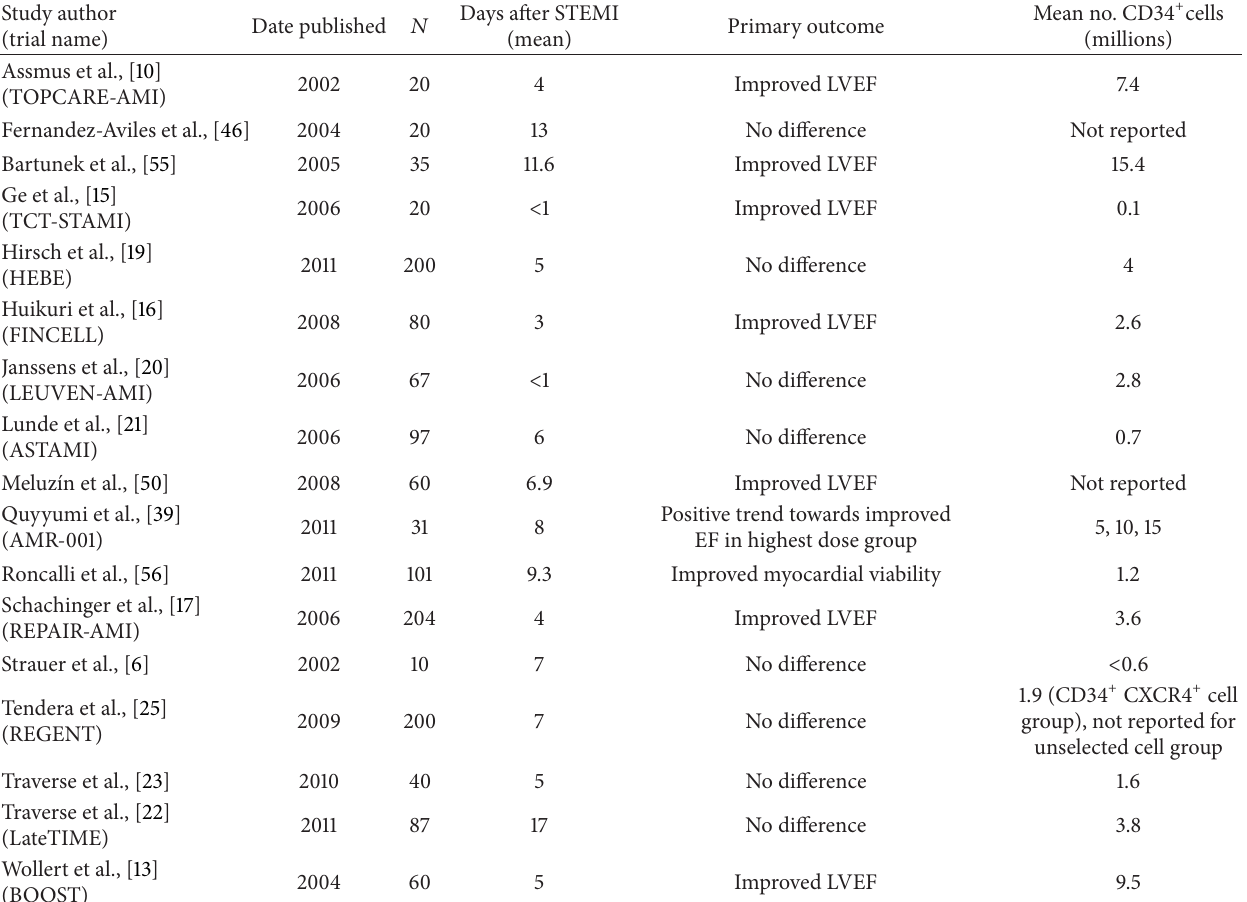
Table 1: Clinical trials of bone marrow cell (BMC) therapy by intracoronary delivery following acute ST-segment elevation MI